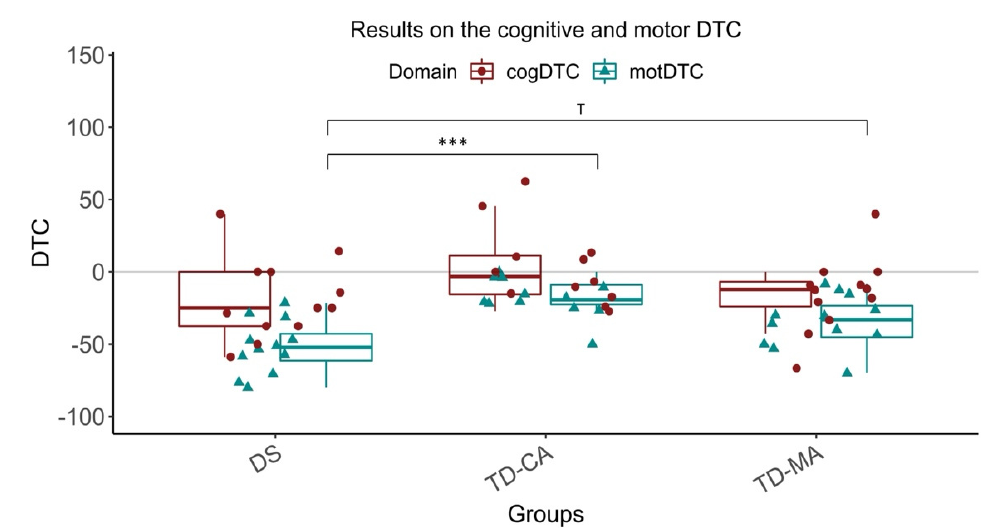
Figure 2. Results on the cognitive and motor DTC in DS, TD-MA, and TD-CA children (*** p < 0.001; T < 0.10). Note: cogDTC = cognitive dual-task costs; motDTC= motor dual-task costs; DS = Down Syndrome; TD-MA = Typically developing children of the same mental age; TD-CA = typically developing children of the same chronological age.